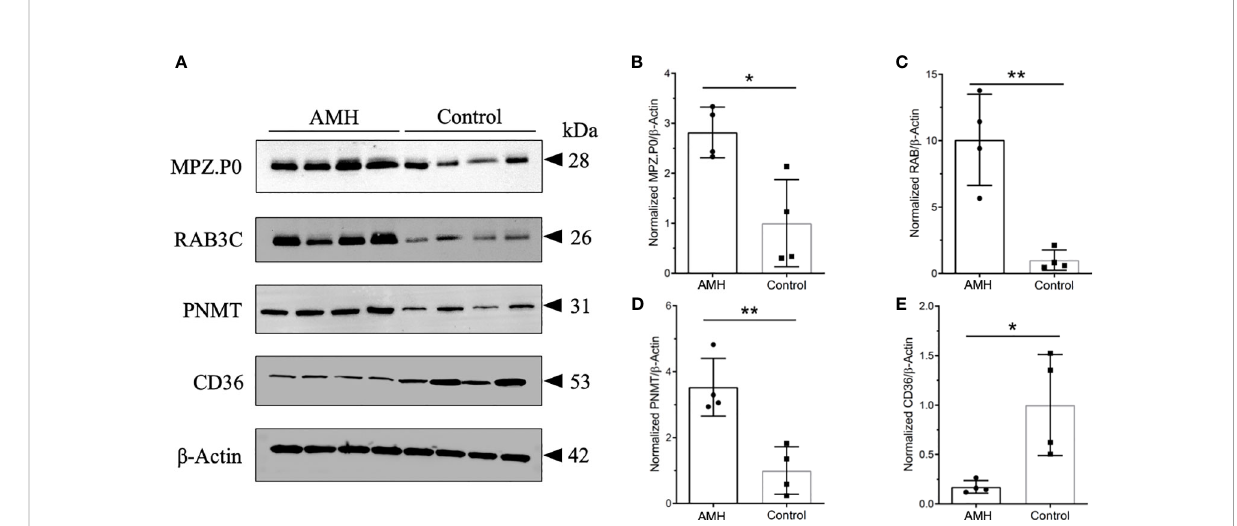
FIGURE 7 Representative Western blots and quanti fi cation results offour kinds of differentially expressed proteins. (A) These four proteins displayed distinctly different expression in AMH and control tissues. MPZ.P0, RAB3C, and PNMT were increased in AMH, whereas CD36 was decreased in AMH in comparison with controls. n = 4 for each group. b -Actin was used as the loading control. (B) Quanti fi cation results of MPZ.P0 normalized to b -Actin. (C) Quanti fi cation results of RAB3C normalized to b -Actin. (D) Quanti fi cation results of PNMT normalized to b -Actin. (E) Quanti fi cation results of CD36 normalized to b -Actin. * P < 0.05, ** P <